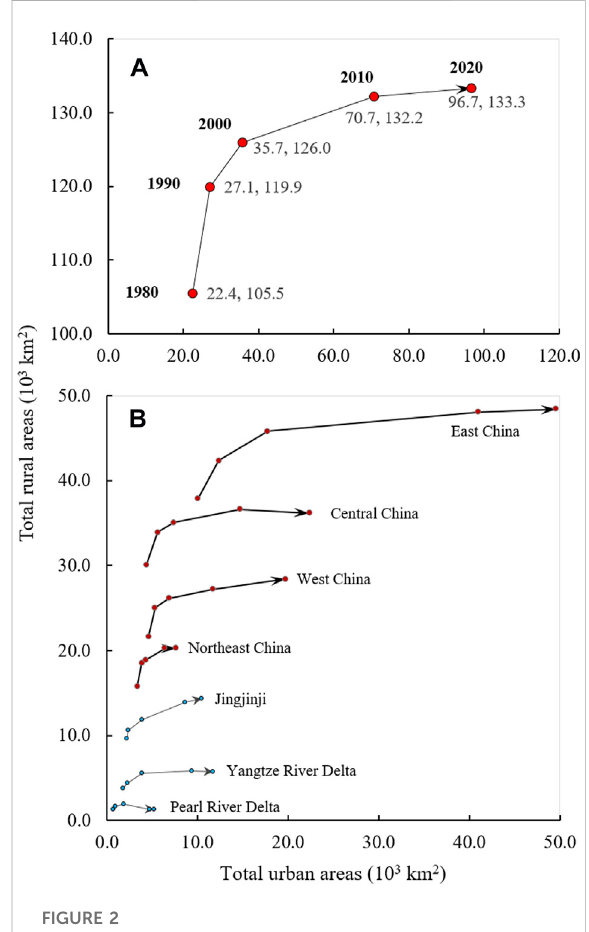
FIGURE 2 Nexus of urban and rural expansions in China (A) , and its sub- regions as well as its three urban developing hot-spots (B) from 1980 to